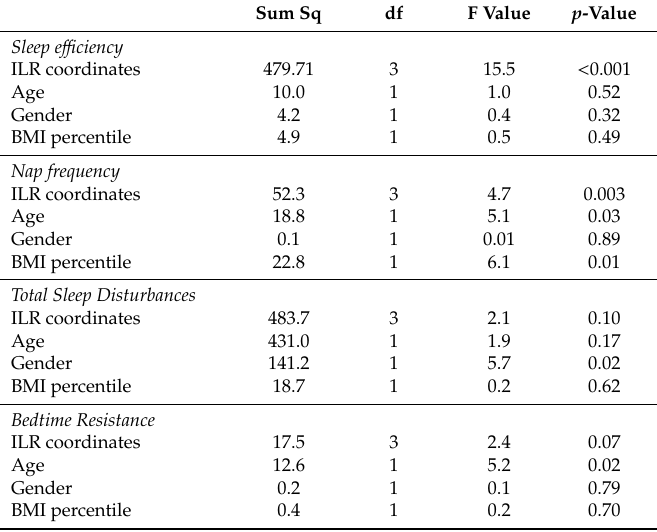
Table 2. Analysis of variance results for sleep outcome baseline linear